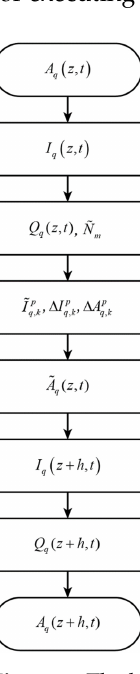
Figure 1. The block diagram of nonlinear operator evaluation.